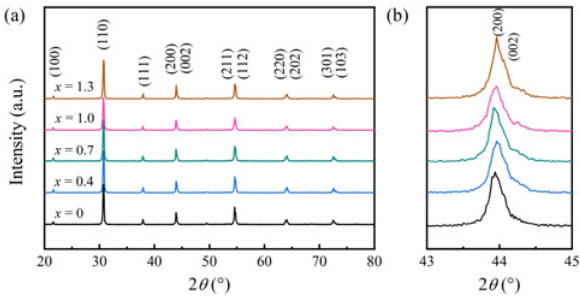
Fig. 3 (a) XRD patterns of the PBLZST: x wt% AlN ceramics at room temperature. (b) Enlarged patterns of 2 θ =